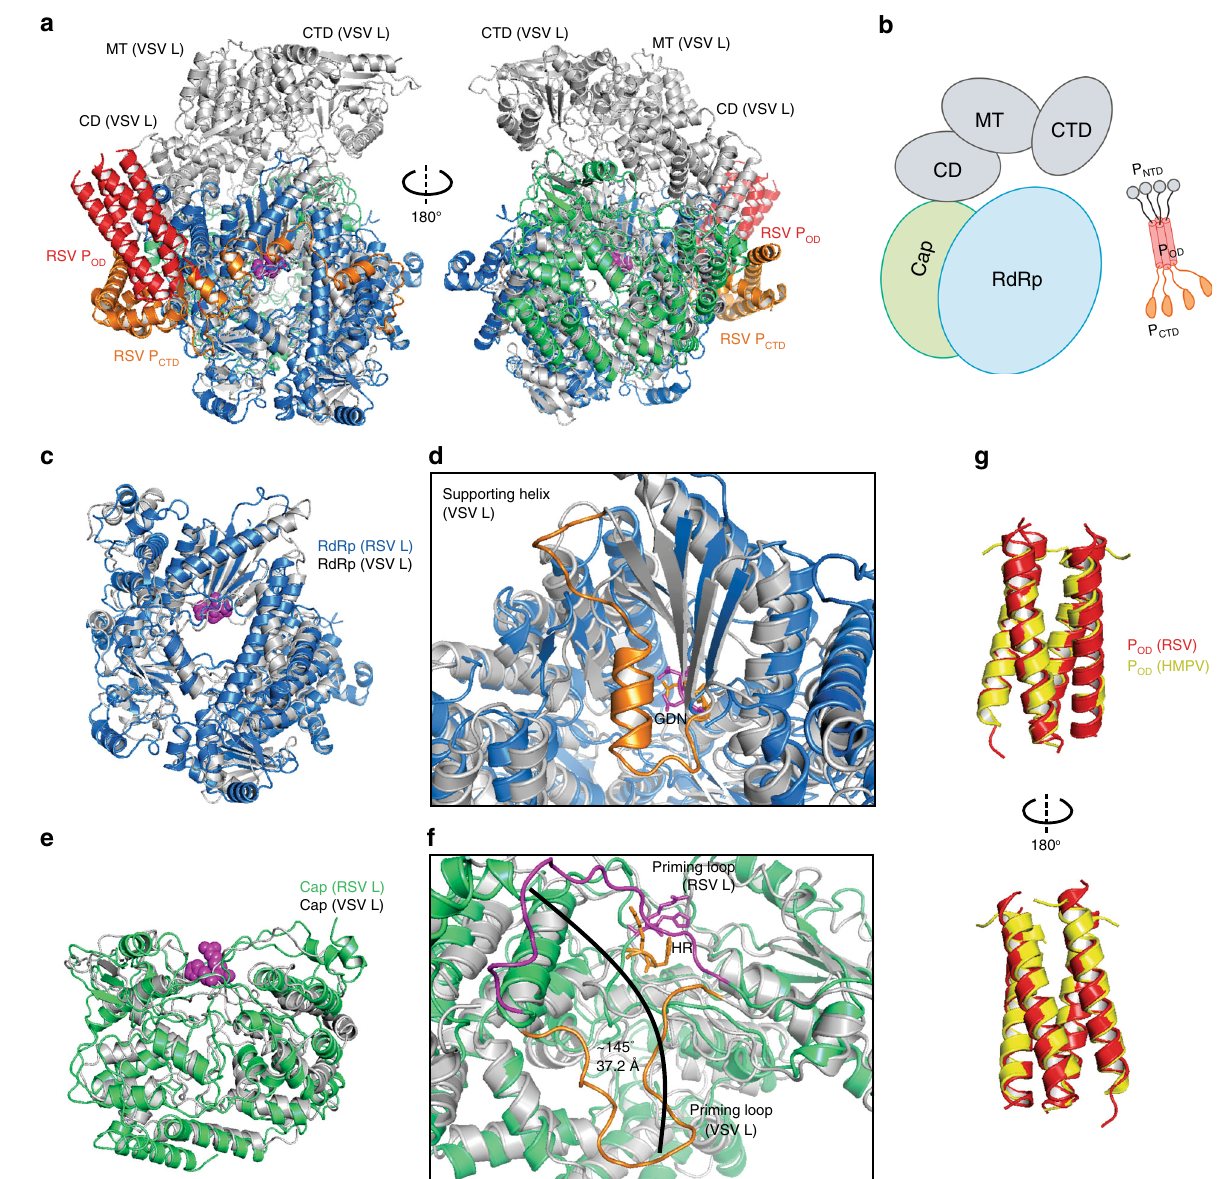
Fig. 3 Structural comparison of the L and P proteins. a Superimposition of the RNA dependent RNA polymerase (RdRp) and capping (Cap) domains of the L protein from RSV (this work) and VSV (PDB: 5A22). RSV L is colored the same as Fig. 2a, and VSV L is colored in gray. b The cartoon representation of the RSV L and P. The missing domains are colored in gray. c Overview of the RdRp domain. d Magni fi ed view showing the core residues (GDN, magenta for RSV, orange for VSV) and the missing supporting helix (orange, VSV L) in the RdRp domain. e Overview of the Cap domain. f Magni fi ed view showing the core residues (HR, magenta for RSV, orange for VSV) in the Cap domain. The priming-loop-like element of the RSV L and the VSV L is highlighted in magenta and orange, respectively. A major shift (~37 Å) from the tip of the priming-loop-like element is shown as the black arrow. g Superimposition of the oligomerization domain of P (P OD ) from RSV (this work) and HMPV (PDB: 4BXT). The HMPV P is in